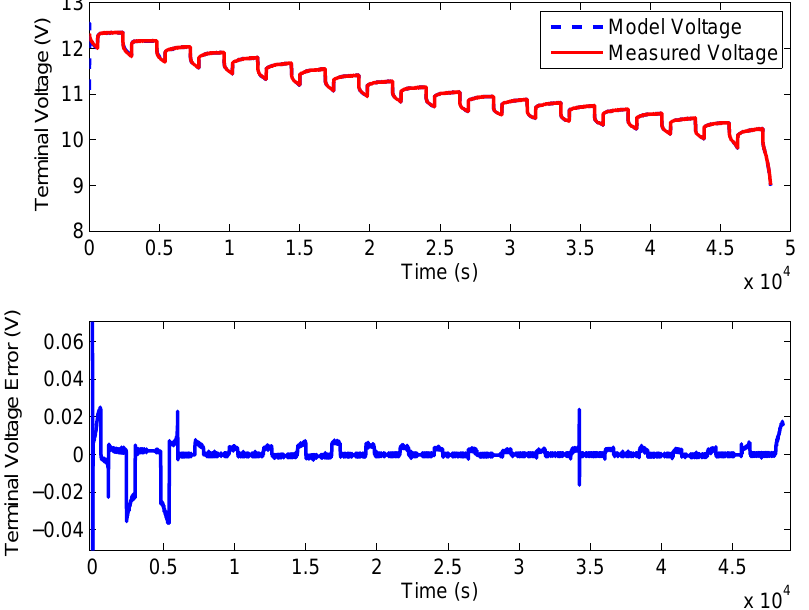
Figure 8. Experimental terminal voltage results using VB-ADEKF in the pulse current discharge test.